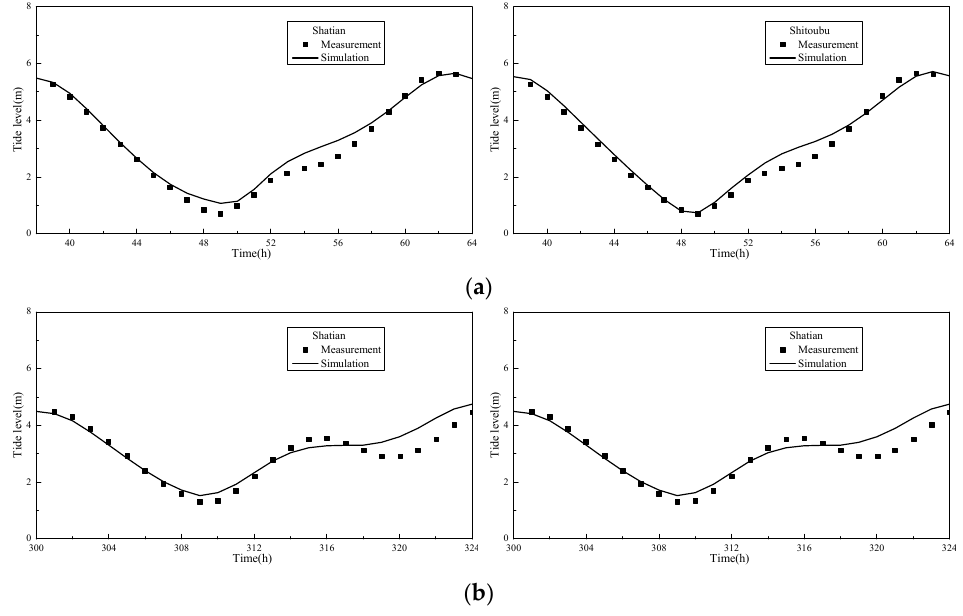
Figure 4. Comparisons of measured and calculated water levels of ( a ) spring tides and ( b ) neap tides.